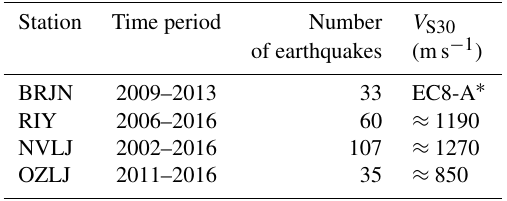
Table 1. Number of analysed earthquakes and V S30 for each station.